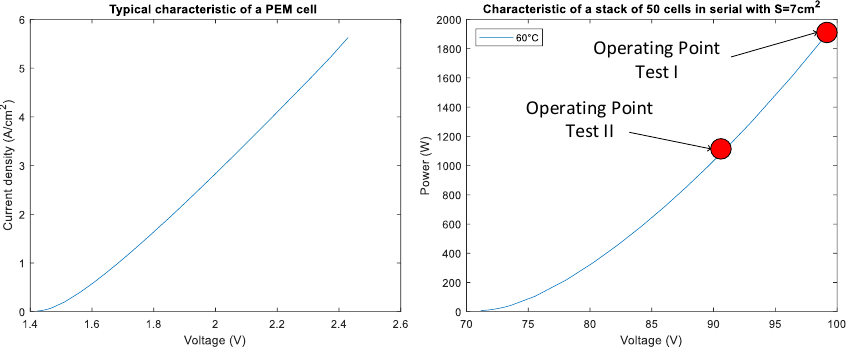
Figure 17. Typical characteristic of a PEM cell ( left ) and power as a function of voltage across a stack of 50 cells in series ( right ).